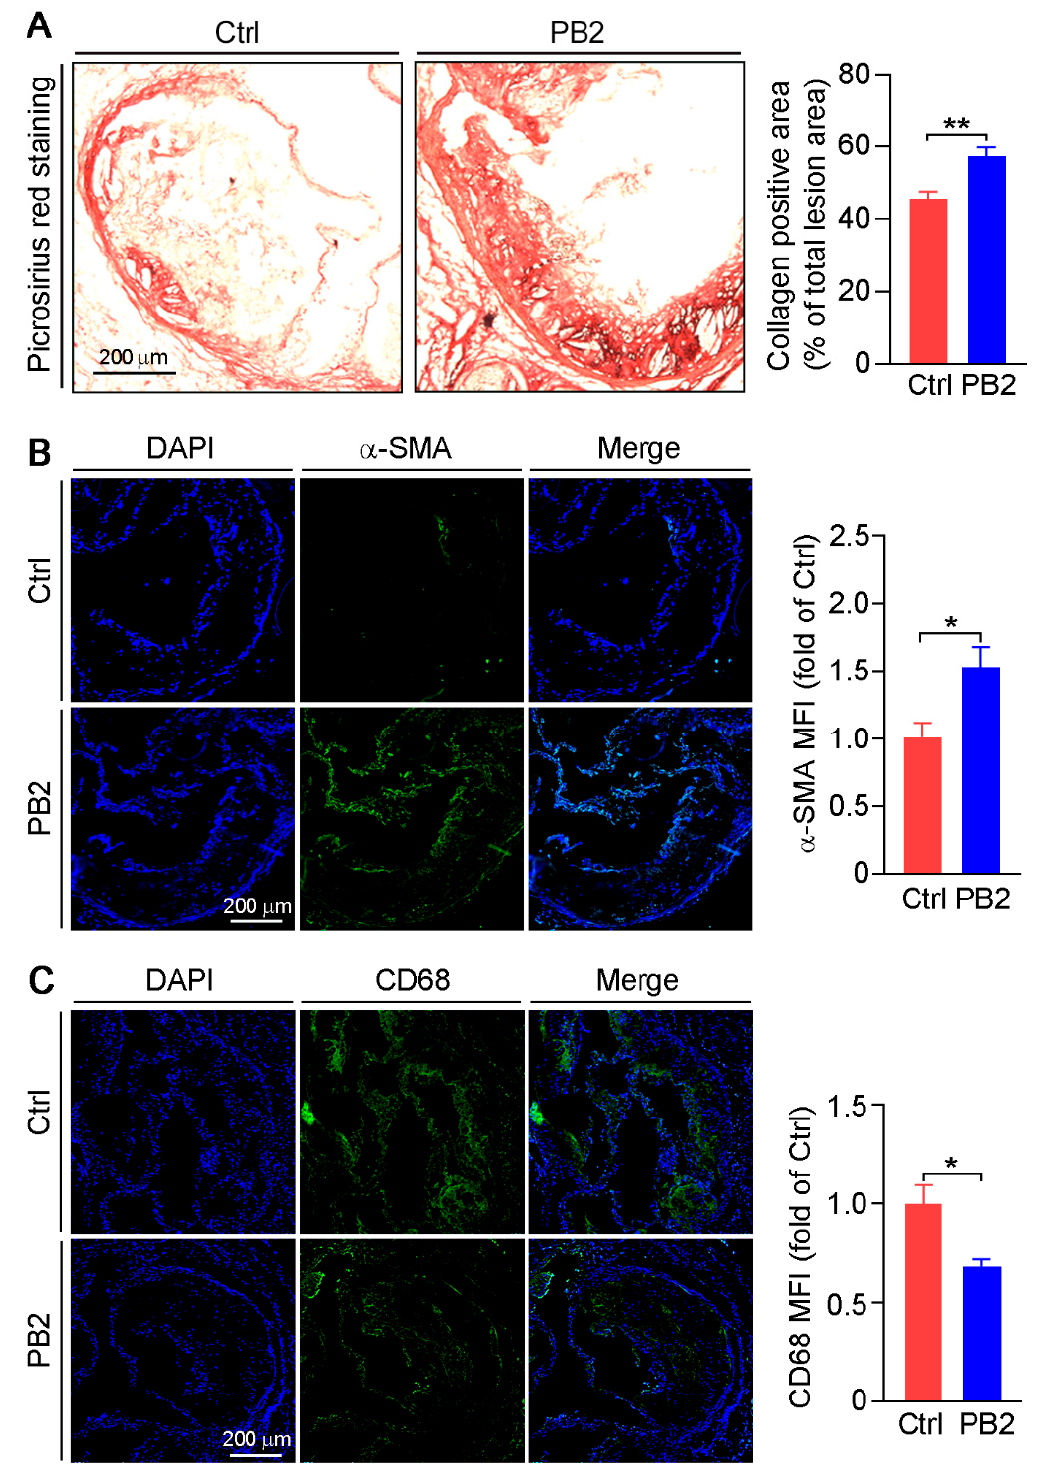
Figure 2. The effects of procyanidin B2 on collagen content and cell composition in lesion areas of aorta root cross sections. ( A ) Collagen content in arterial wall was determined by Picrosirius red staining. ** p < 0.01 (10 mice per group were used, and at least three samples from each mouse were taken as technical replicates). The expression of α -SMA ( B ) and CD68 ( C ) was determined by the immunofluorescent staining of cross sections of the aortic root with the quantitative analysis of mean fluorescent intensity (MFI). * p < 0.05 (10 mice per group were used, and at least three samples from each mouse were taken as technical